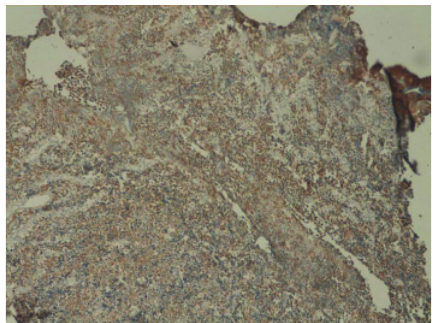
Figure 4: Observed structures all of which were of tumoral quality. Patchy vascular structures were apparent. Frequent mitotic activities were present. Immunohistochemical studies showed a positive staining with